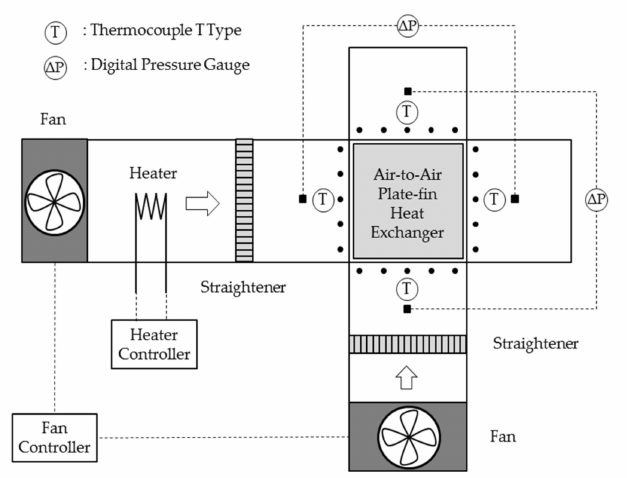
Figure 4. Schematic diagram for measuring the performance of air temperature, airflow rate, and pressure drop of the plate-fin heat